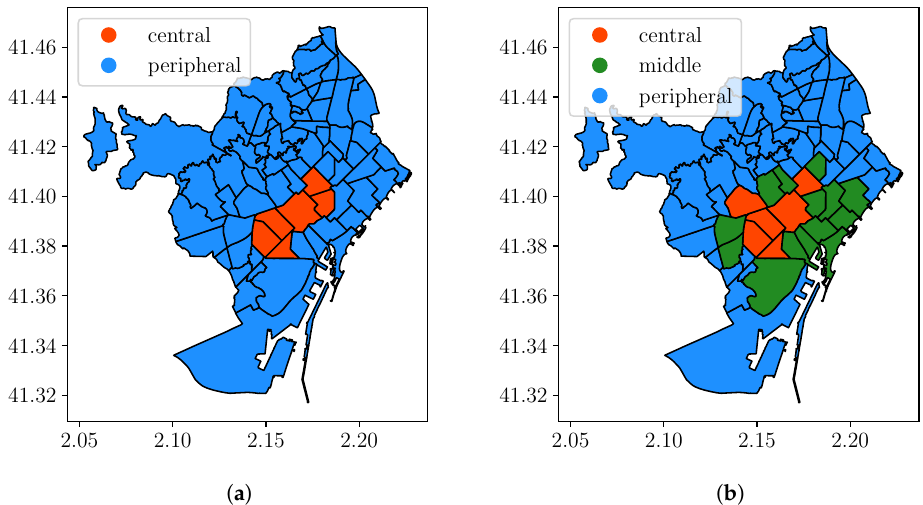
Figure 8. The two types of city’s areas division. Central, middle and peripheral neighbors are defined by the number of requests on the right and by the presence of most neighborhoods on the left: ( a ) Two-zones type, the central area is represented by Eixample district; ( b ) Three-zones type, the neighborhoods are classified according to the number of requests. Table 1. Three-zones division resulting areas and relative thresholds.